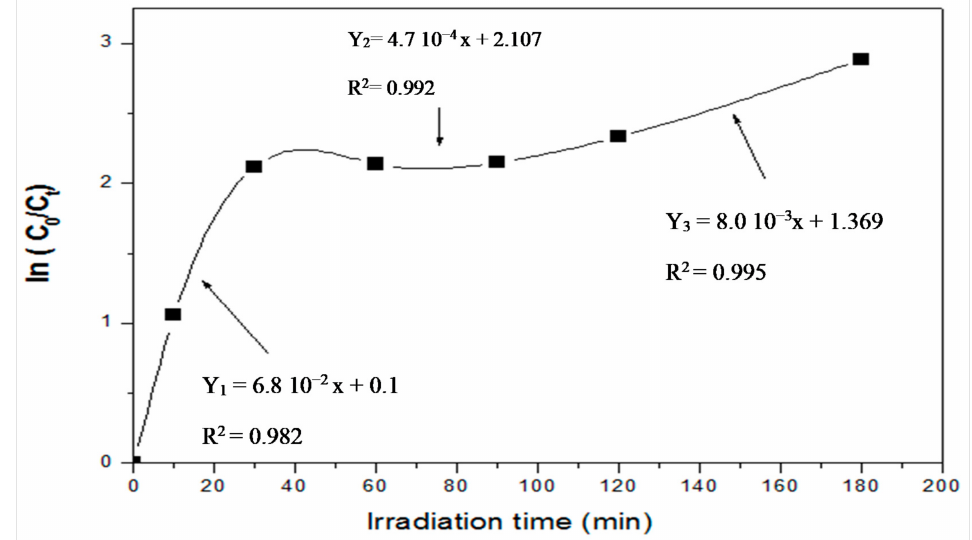
Figure 8. Plot of the pseudo-first-order model of CV dye photocatalytic